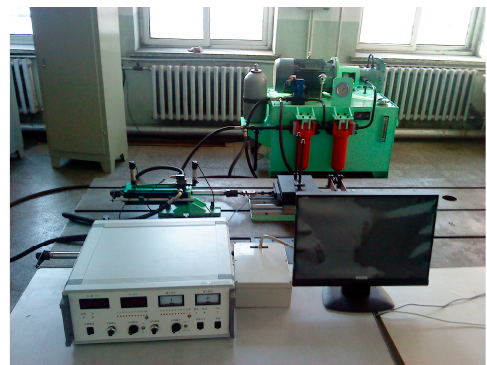
Figure 12. Semi-physical simulation test bench.